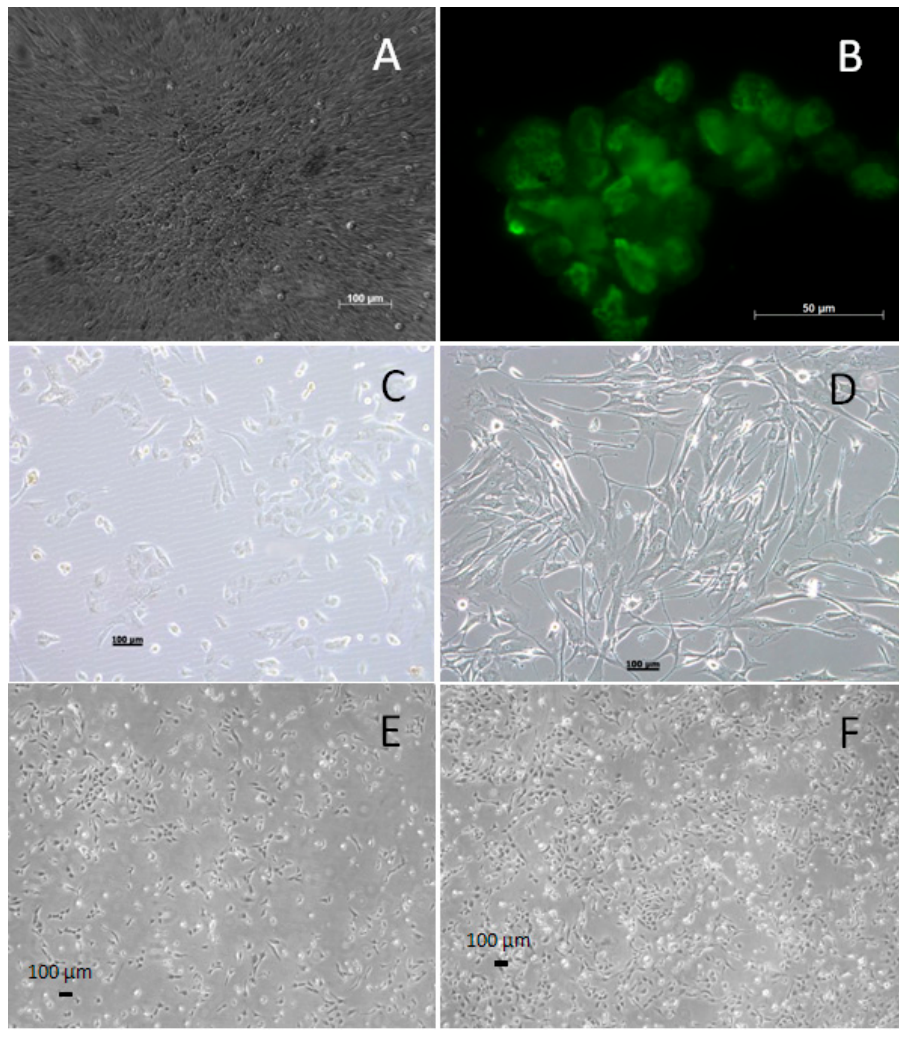
Figure 1. ( A ) Initial foci of transformed cells 26 days post-transfection in the bright field microscope. Foci are clearly distinguishable among the cultured and transfected cells. ( B ) GFP-labeled T-antigen expression in transfected cells. ( C ) Immortalized confluent WG-59 in comparison with non-transfected, primary confluent VSMCs; 10-fold enlargement ( D ). ( E ) WG-59 cell culture, third day of 20. Passage; 10-fold enlargement. ( F ) WG-59 cell culture, sixth day of 20. Passage; 10-fold enlargement.